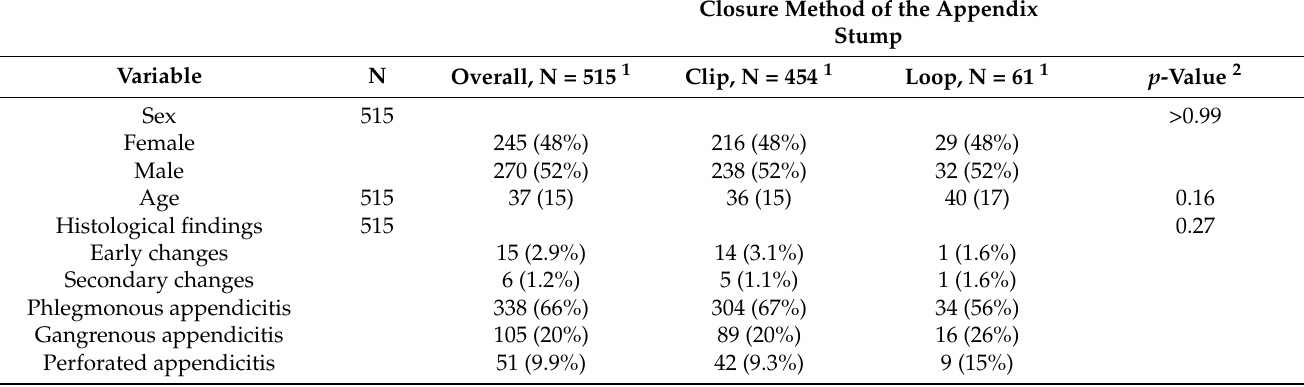
Table 2. Clinical characteristics of two groups (clips group and loops group) of patients who under ‐ went laparoscopic appendectomy.